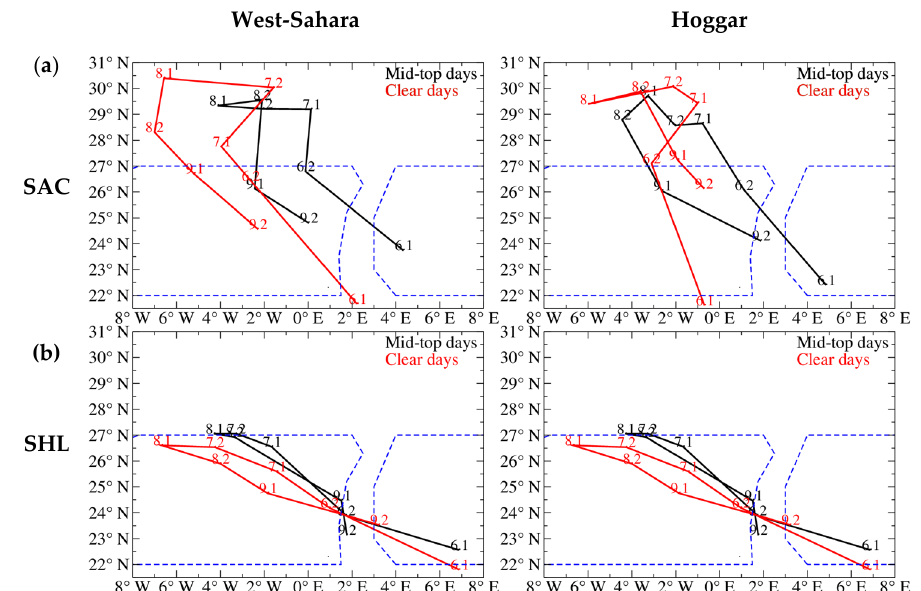
Figure 9. ( a ) Position of the SAC in a latitude-longitude coordinate frame for mid-top (black) and clear days (red). ( b ) Position of the SHL for mid-top (black) and clear days (red). Average over 15 day periods of the daily positions. Numbers indicate the month (i) which fall in the first fraction (i.1) or second fraction (i.2). Information given for West-Sahara (left column) and for Hoggar (right column). The dotted blue lines give a rough representation of Hoggar and West-Sahara boundaries.